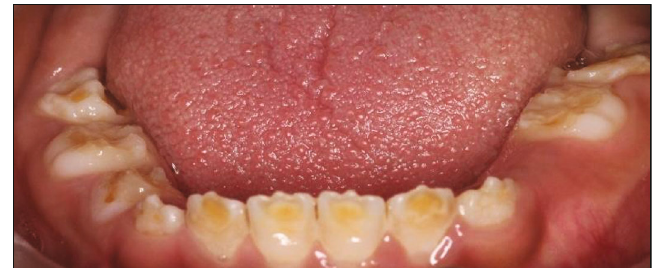
Figure 3: Lower occlusal arch.